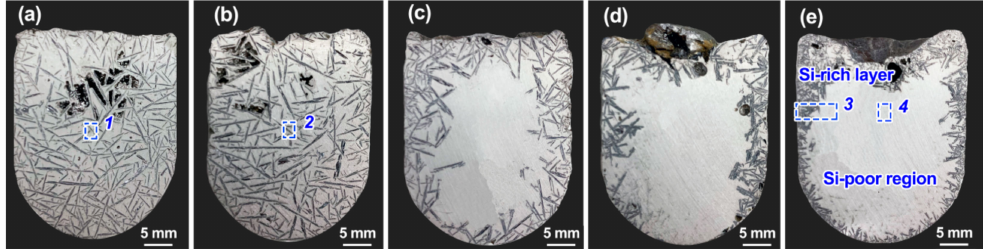
Figure 3. Vertical-section images of Al-30Si alloy with di ff erent conditions: ( a ) without rotating magnetic field (RMF), ( b ) 600 mT static magnetic field (SMF), ( c ) 5 mT RMF, ( d ) 15 mT RMF and ( e ) 25 mT